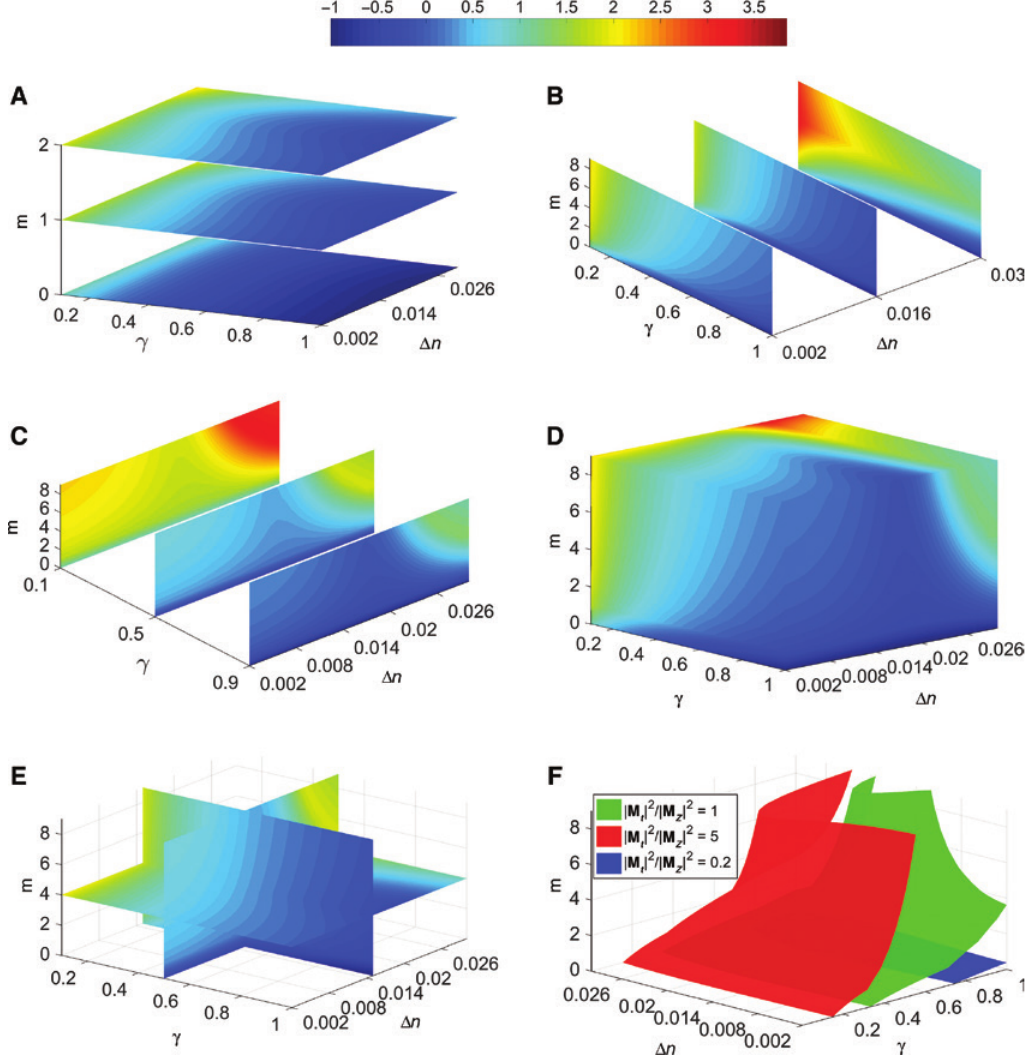
| 2 / | M | 2 in the parameter planes and space. Figure 5: Plots of | M t z (Color online) Magnetization distributions in (A) 2D Δ n - γ parameter plane, (B) 2D m - γ parameter plane, (C) 2D Δ n - m parameter plane, and (D) 3D Δ n - γ - m parameter space. (E) Distributions inside the Δ n - γ - m parameter space. The value of | M scale. (F) Three isosurfaces representing three different configurations: the longitudinally dominated, the transversally dominated, and the longitudinal and transverse balanced